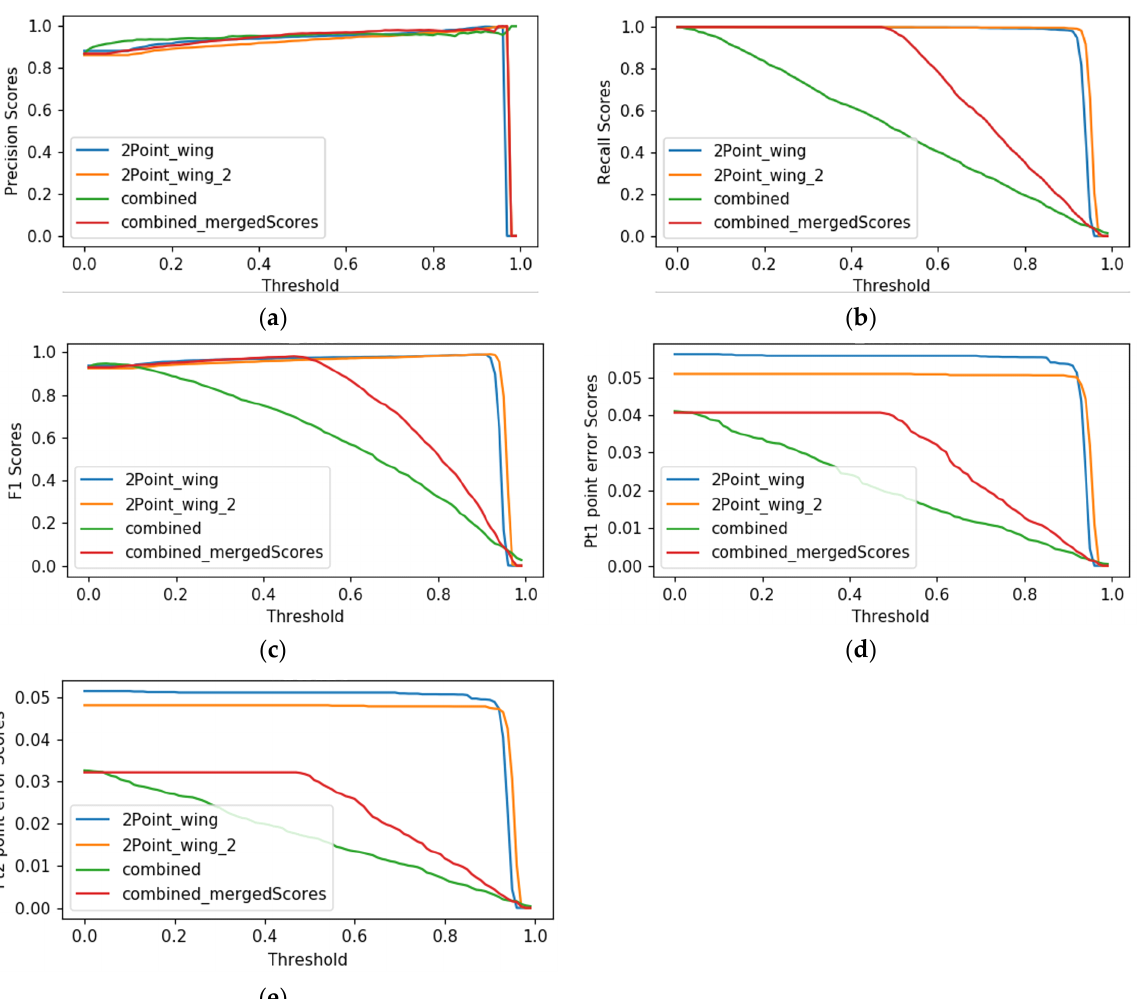
Figure 9. Results of two-step identification algorithm for the AOLP database: ( a ) precision scores; ( b ) recall scores; ( c ) F1 scores; ( d ) Pt1 point error scores; ( e ) Pt2 point error scores.